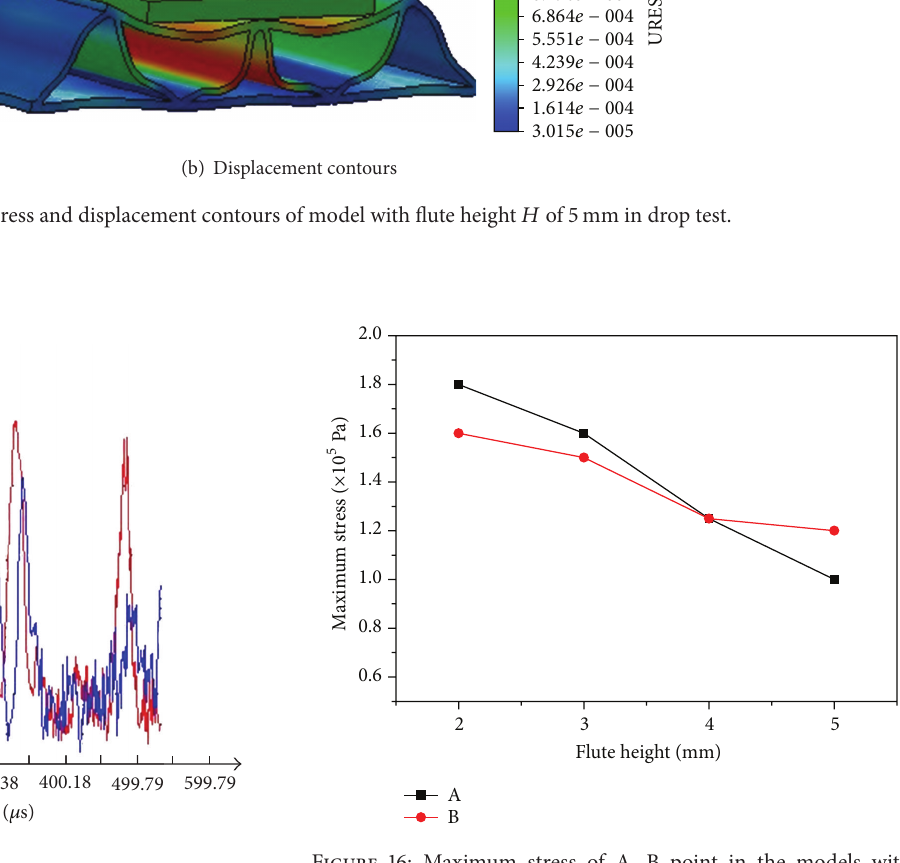
Figure 16: Maximum stress of A, B point in the models with different flute height 𝐻 in the drop